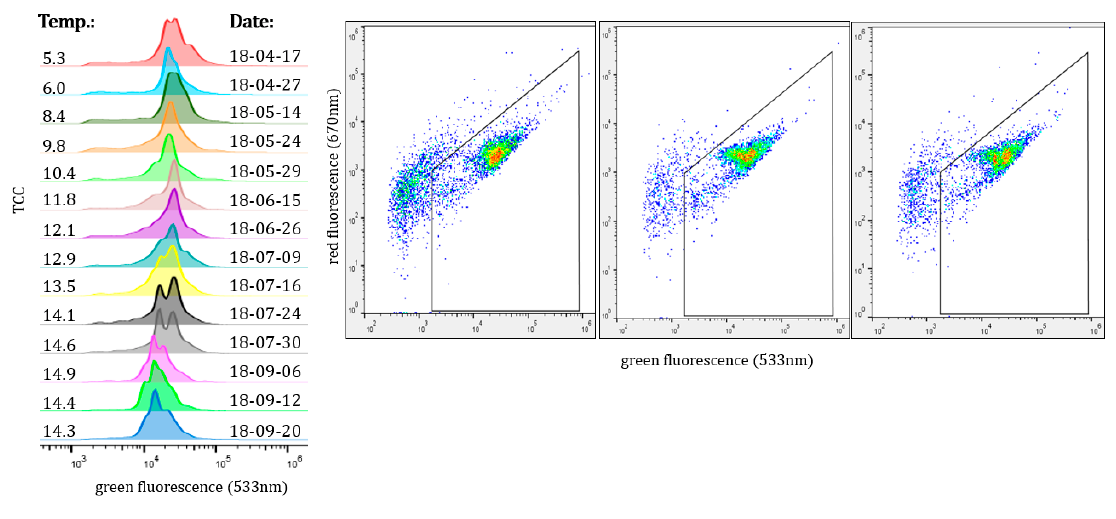
Figure 3. Changes in the bacterial community over season at Masar. FCM fingerprints (left panel) from sampling in April 2018 to September 2018 show a shift to increasing proportions of low nucleic acid (LNA) bacteria, likely due to an increase in water temperature during summer. Scatterplots (right panel) show individual cells within the population, the gate applied, and a gradual increase in intensity corresponding to more cells with LNA (sampling date for left to right: 27 / 04 / 18; 16 / 07 / 18; 24 / 07 / 18). As expected, more bacterial growth (regrowth) was observed when the temperature in the water rose. Increasing TCC and temperature were also observed at Tofta, Tronn, and BlaSc, with ◦ 7000 ± 6200 cells / mL and water temperature: 7.2 ± 1.4 C during spring, rising to 34,300 ±